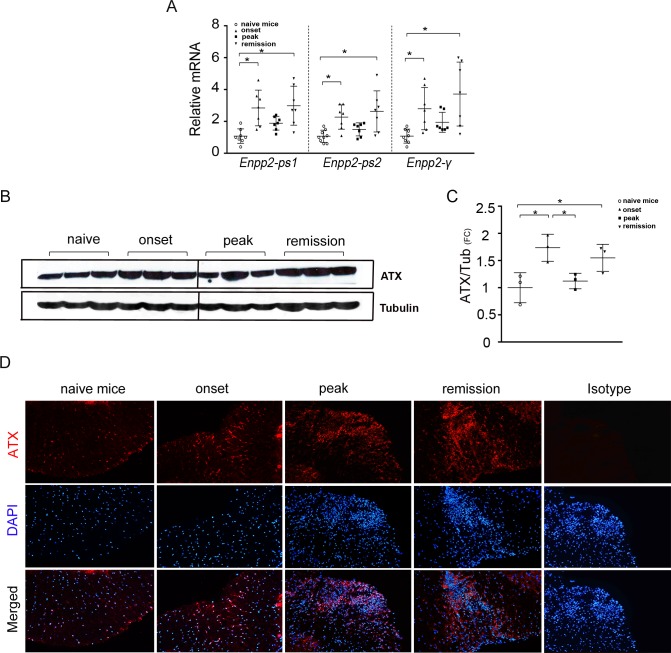
Increased ATX expression levels in the inflamed spinal cord upon EAE.(A) Q-RT-PCR analysis of total ATX (Enpp2) mRNA levels (with two different set of primers; ps1-2), as well as of the ATX brain-specific γ isoform in whole spinal cord lysates. (B) Immunodetection of ATX expression in the spinal cords at different EAE time points with monoclonal antibody 4F1; the full membrane is shown at S3 Fig). (C) Densitometry analysis of B; Expression was normalized to the levels of β-tubulin. (D) Representative immunofluorescent staining of spinal cord sections from the lumbar region from mice sacrificed at different time points post immunization with an anti-ATX antibody (Cayman). Naïve, onset and peak images taken from the ventral area of the slides, remission image taken from the dorsal funicular region. All values are presented as mean (±SD); Statistical significance between experimental groups was assessed with one-way ANOVA complemented with Bonferroni or Dunn's multiple pair test; *denotes statistical significance (p<0.05).